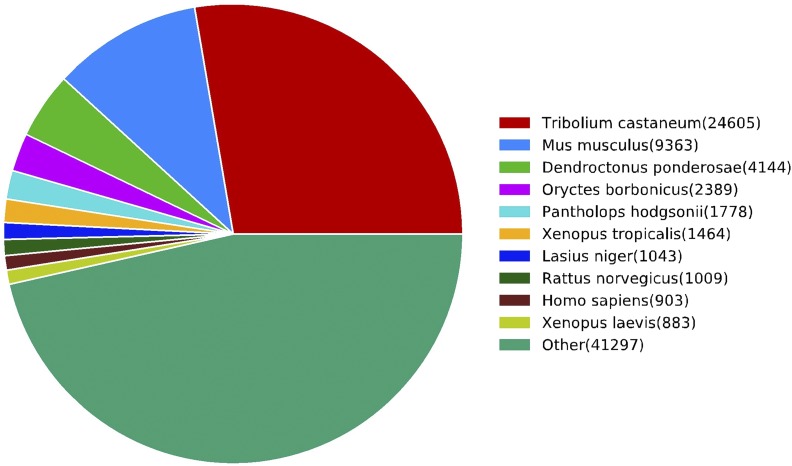
Distribution of species in the NCBI non-redundant protein database The species were determined based on the highest score of all of 191, 246 unigenes in the BLASTX results.